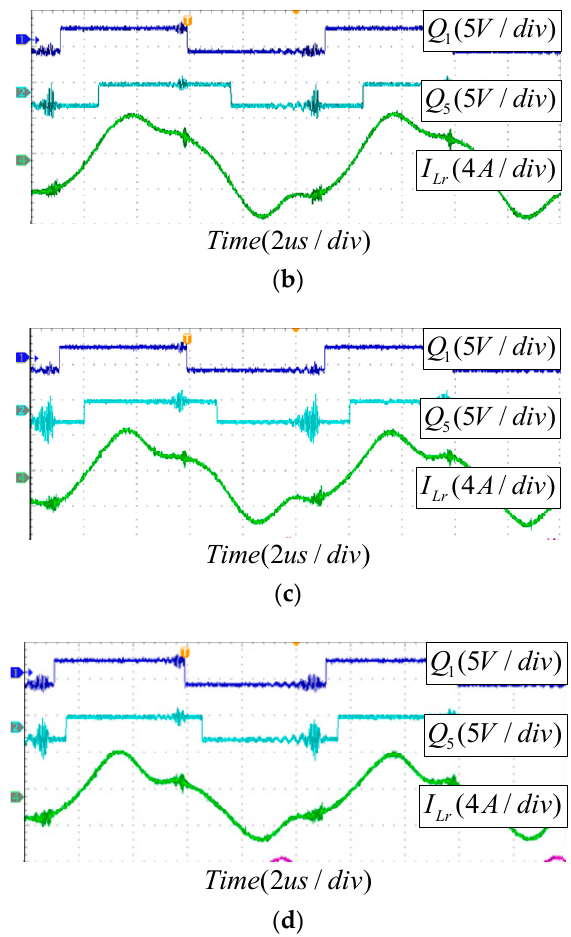
Figure 11. Relationship between the current and the driver in the steady state. ( a ) Output voltage 150 V; ( b ) output voltage 130 V; ( c ) output voltage 90 V; and ( d ) output voltage 70 V. The output voltage